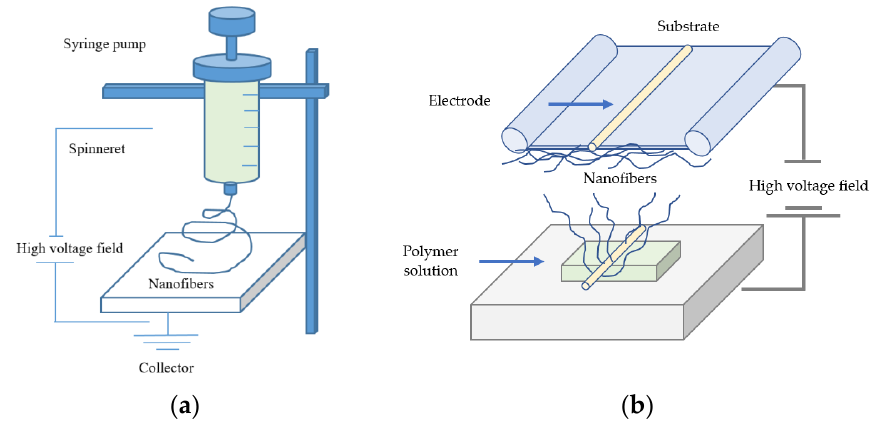
Figure 1. ( a ) A basic setup of needle-based and ( b ) needleless electrospinning methods.